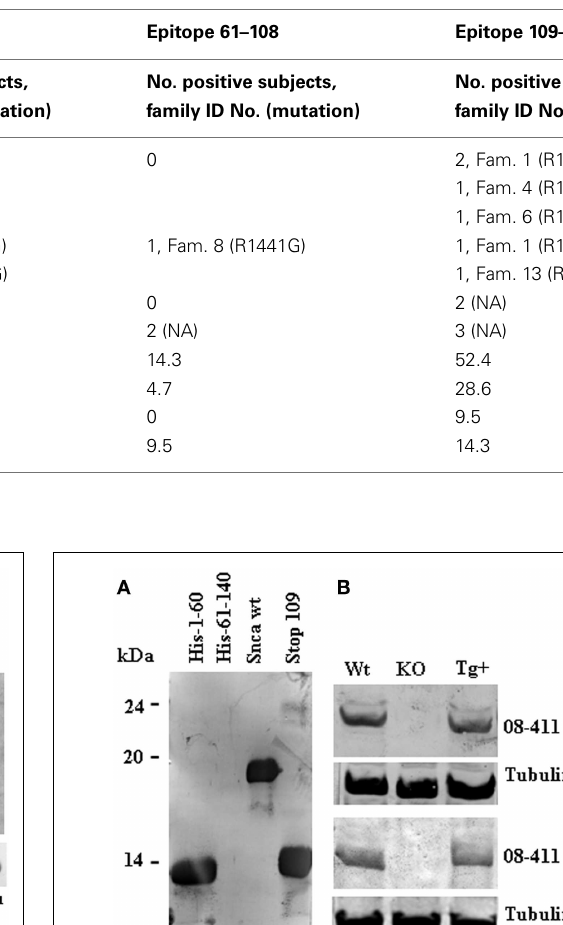
Table 2 | Epitopes of positive anti-Snca antibodies .